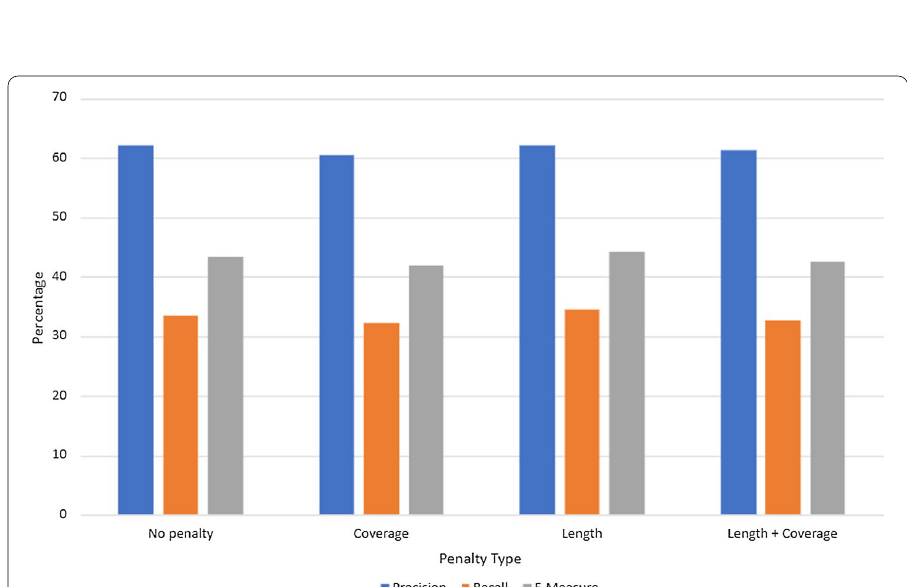
Fig. 6 Results comparison of baseline model with copy